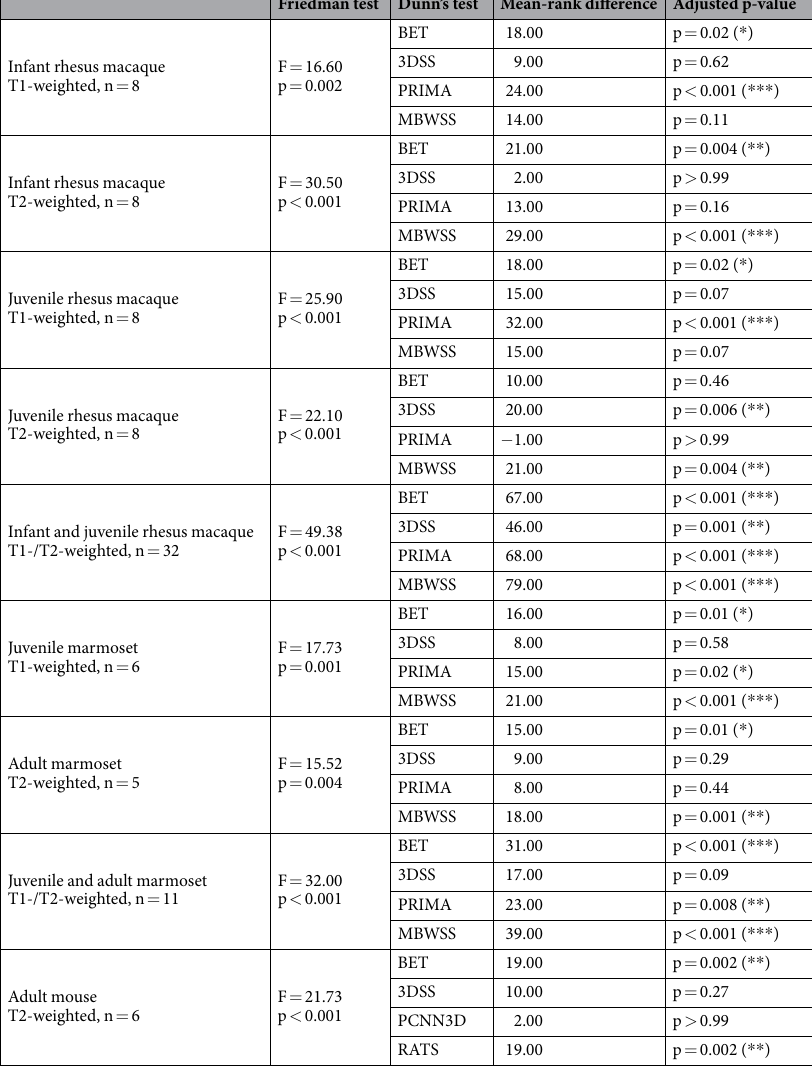
Table 1. Results from comparative analysis. Comparative analysis between atlasBREX (ABX) and alternate technical methods (each group tested against the results from ABX) was performed using Jaccard-Index